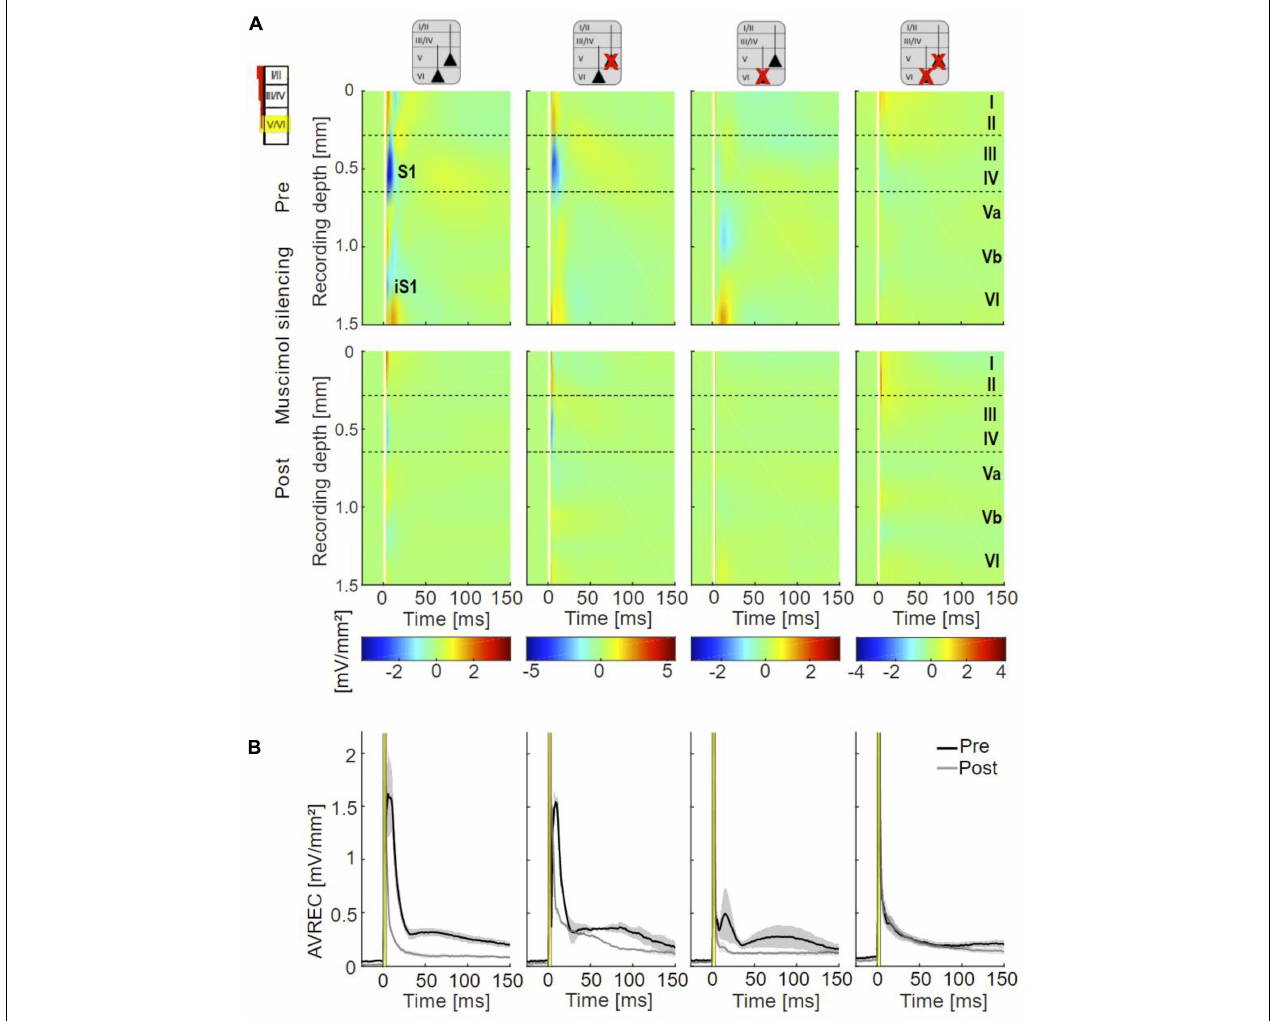
FIGURE 5 | Cortical responses evoked by infragranular ICMS. (A) Averaged CSD profiles of all four groups (non-Les, LesV, LesVI, LesV+VI) evoked by infragranular ICMS (160 µ A, stimulus artifact masked by white line), before (top) and after (bottom) application of muscimol. In the untreated condition, non (or weakly) lesioned animals show a cross-laminar activation pattern similar to that evoked by acoustic stimulation. In animals with considerable loss of layer VI neurons, S1 is much smaller than in non-lesioned animals and other rather weak sinks are observed in extragranular layers. After cortical silencing with muscimol, animals without lesions in layer VI display the two initial sinks (S1, iS1) also seen upon acoustic stimulation in the silenced cortex. In contrast, both groups with layer VI lesions lack or have only a very small S1. In the LesVI group, only weak activation remained present, while in animals with exclusive (LesV) or additional (LesV+VI) loss of layer V neurons, a stronger and longer lasting pattern of sinks and sources was observed. n non − Les = 6, n Les5 = 2; n LesVI = 4; n LesV + VI = 6 (pre), 5 (post). (B) Grand-averaged AVREC curves evoked by layer-specific infragranular ICMS in the untreated (black) and silenced (gray) condition, showing means (solid lines) and SEM (shaded areas) of the different lesion groups. The first short peak represents the stimulus artifact (labeled by a yellow box). Before cortical silencing, strongest activation is seen in non-lesioned animals. After application of muscimol a more sustained activation was seen in animals that involved lesions in layer V, while curves of animals having no or pure layer VI lesions declined rapidly to very low